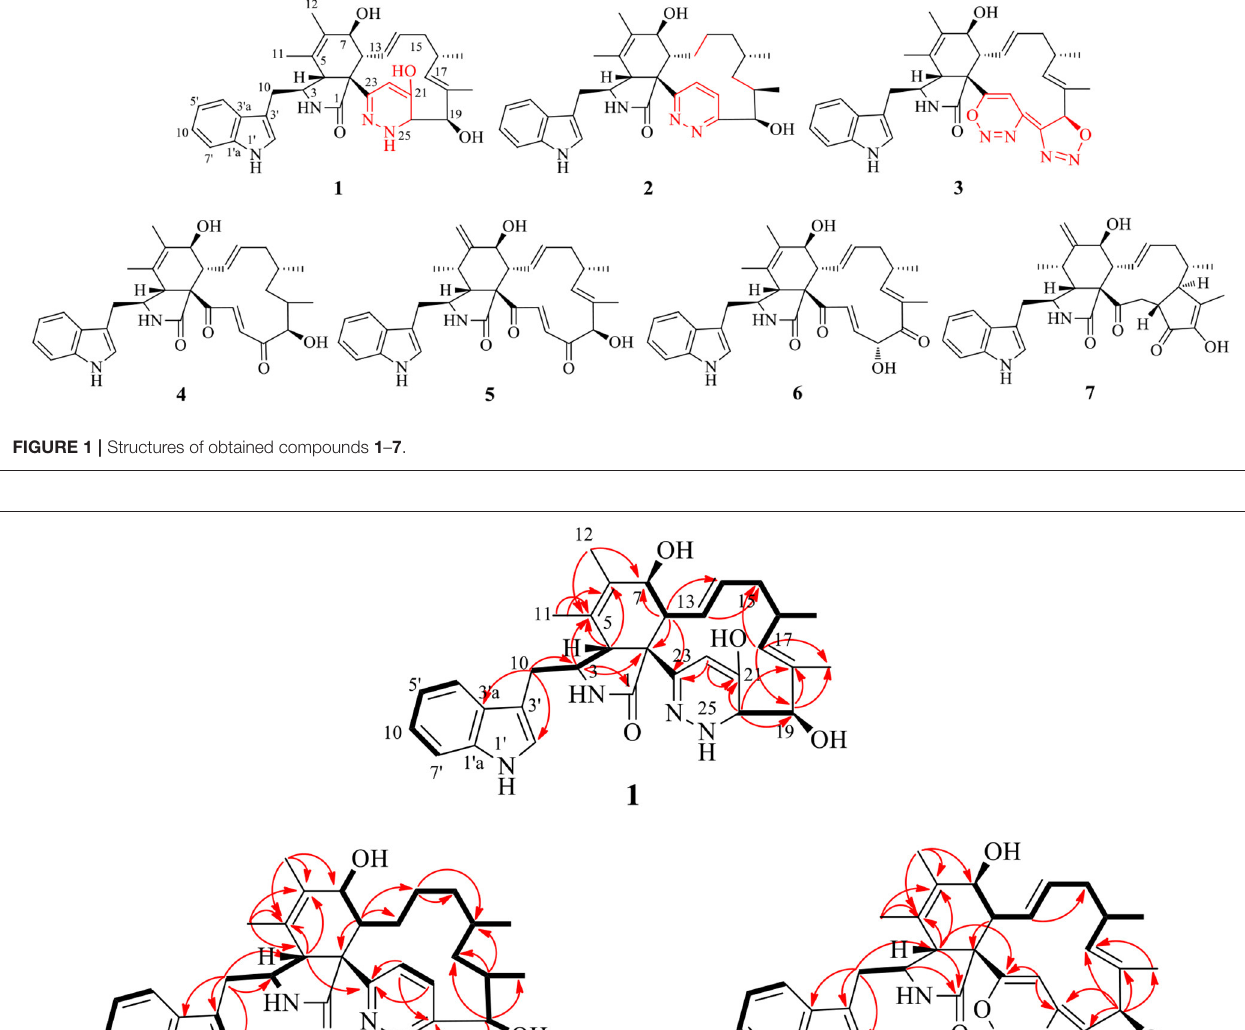
the proton and carbon resonances at δ H 7.76 (br d, 8.7, H- 22) and C-21 (125.1) in 2 . Furthermore, the observed 1 H- 1 H COSY correlation ( Figure 2 ; Supplementary Figure 13 ) of H- correlations ( Figure 2 ; Supplementary Figure 15 ) from H-19 to C-17, C-18-Me, and C-20, from H-21 to C-22 and C-23, from H-22 to C-20 and C-21, and from H-4 to C-23 confirmed the above deduction. The configuration of 2 at H-3, H-4, H- 7, H-8, and H-16 was defined to be identical to 1 and known chaetoglobosin B based on the comparison of the NMR